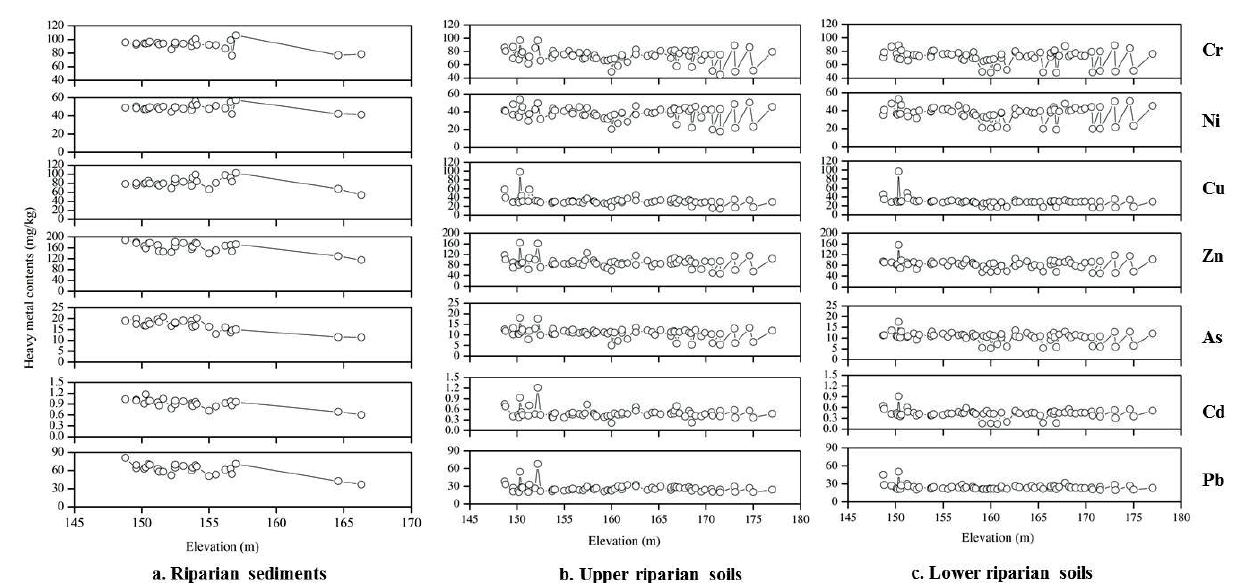
Fig. 3 Distribution of the contents of heavy metals in: (a) riparian sediments; (b) upper riparian soils; and (c) lower riparian